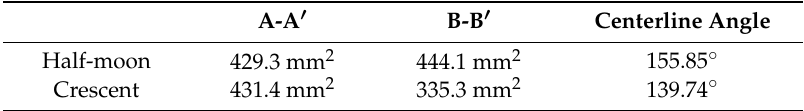
Table 1. Geometric difference between half-moon and crescent models in terms of cross-section areas at A-A’ and B-B’ as well as the centerline angle.